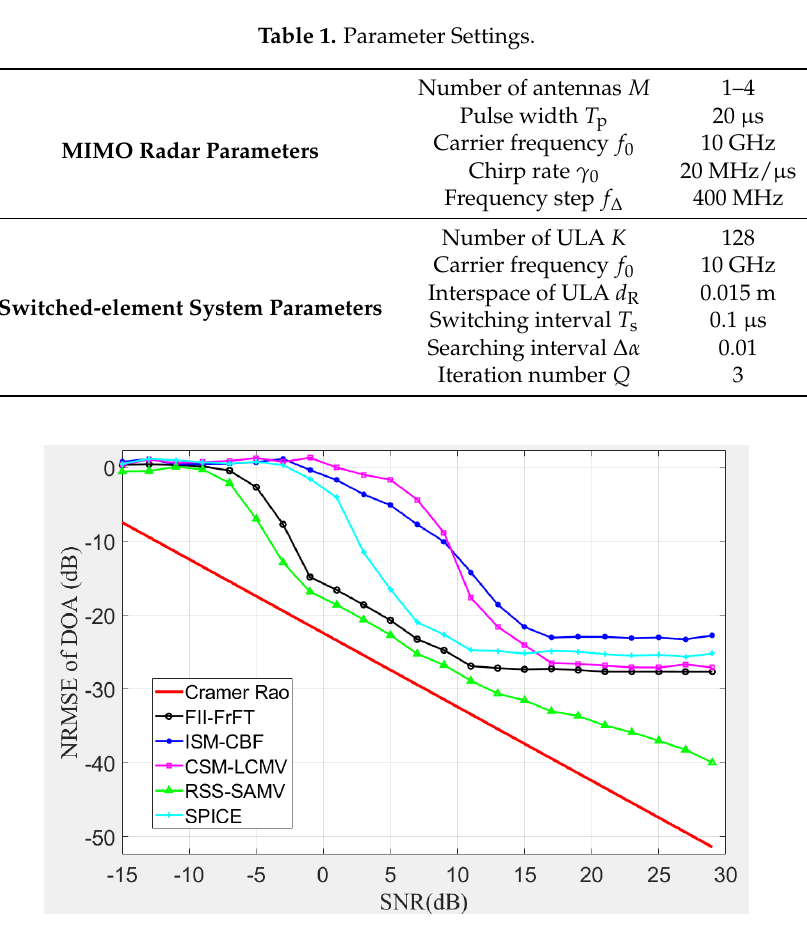
Figure 3. Normalized root mean square error (NRMSE) of DOA versus the signal-to-noise ratio (SNR). Cramer Rao, FII-FrFT, ISM-CBF, CSM-LCMV, RSS-SAMV and